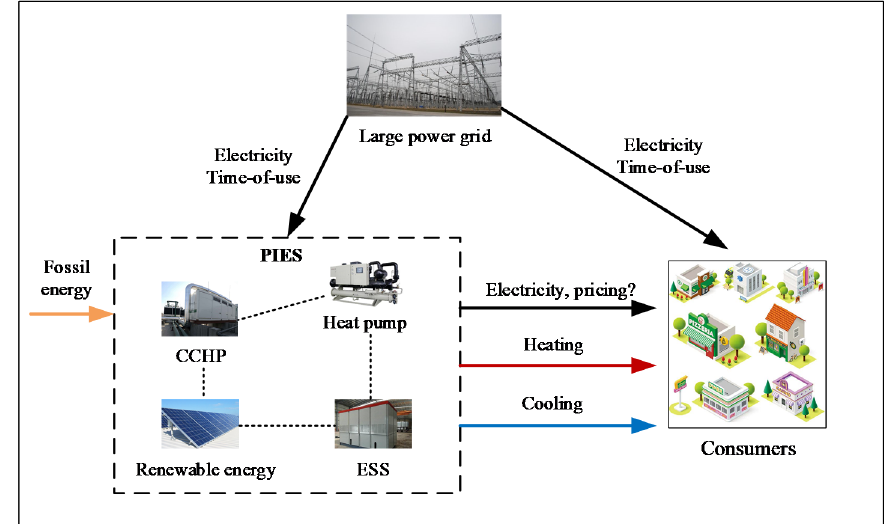
Figure 1. Location and function of a park-integrated energy system (PIES) in an urban energy system.